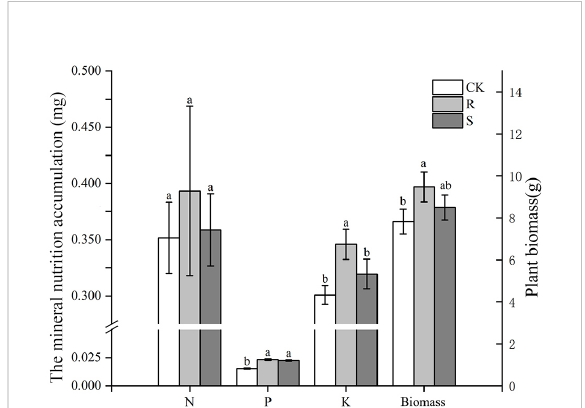
FIGURE 1 The mineral nutrition accumulation (N, P, and K) and biomass of white clover in different treatment. CK, sterilized soil from rhizosphere mixed with sterilized sand and vermiculite; R, soil and fi ne roots from rhizosphere mixed with sterilized sand and vermiculite; S, only soil from rhizosphere mixed with sterilized sand and vermiculite. Data (means ± SD, n = 3) followed by different letters indicate that values are signi fi cantly different ( p < 0.05) within the treatments.